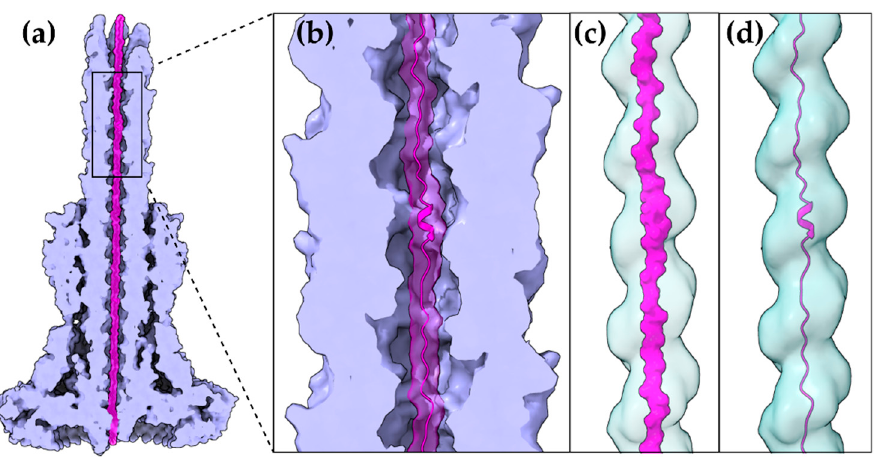
Figure 2. A T3S effector trapped inside the secretion tunnel. The T3SS needle complex atomic structure of Salmonella enterica was determined in two functional states. Here with the secretion substrate trapped inside (PDB id 7ahi) [21]. ( a ) A calculated 5 Å map of the atomic model is shown for simplicity. Substrate is displayed in magenta, T3SS needle complex in light purple. ( b ) Zoom on the needle and the secretion tunnel. ( c , d ) Smoothed surface of the tunnel displayed in light blue. The tunnel has a right-handed helical grooved surface and is wide enough to allow secretion substrates to form α -helices. In ( c ) the molecular surface representation of the substrate is shown. In ( d ) the cartoon representation is shown.